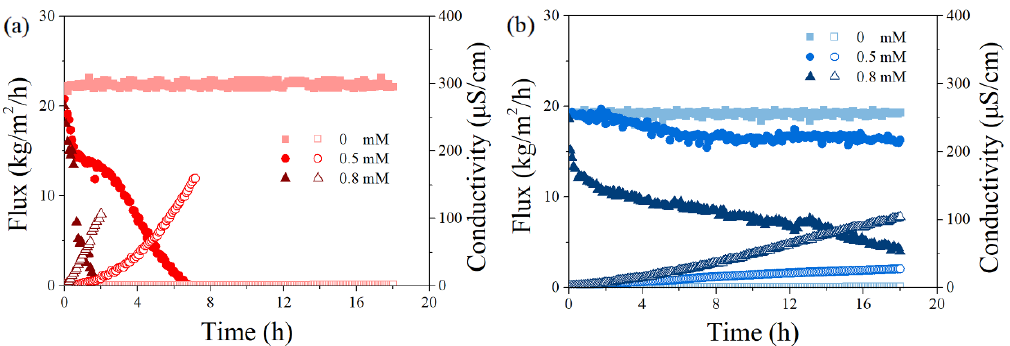
Figure 3. Effect of SDS concentrations (0, 0.5, and 0.8 mM) on permeate flux and permeate conductivity versus time for PVDF ( a ) and PTFE ( b ) for a feed with 5 g/L NaCl at the temperature gradients (T f –T p ) of 50 °C, T f = 65 °C. The flow rates for feed and permeate were 500 and 200 mL/min, respectively. The herein salt rejection rate (>99%) was not significantly different from each case and thus is not shown.